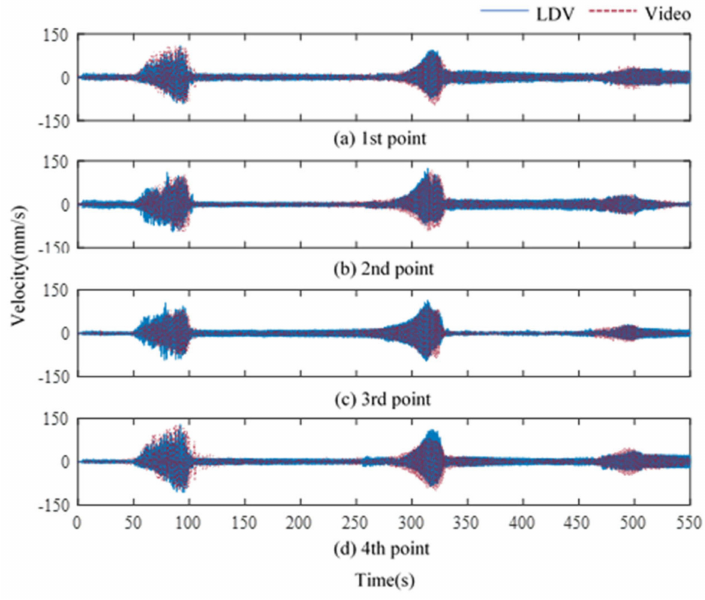
Figure 11. Comparison between time histories of the LDV and video